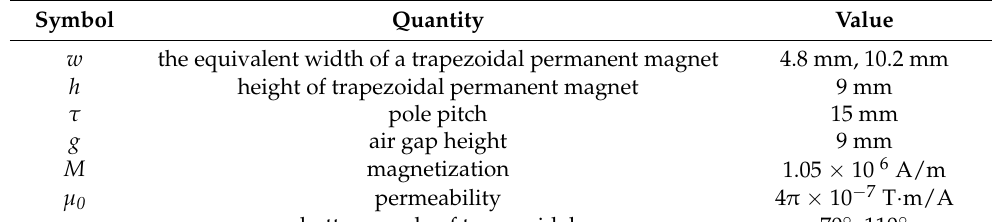
Table 1. Structural parameters of THPMA.